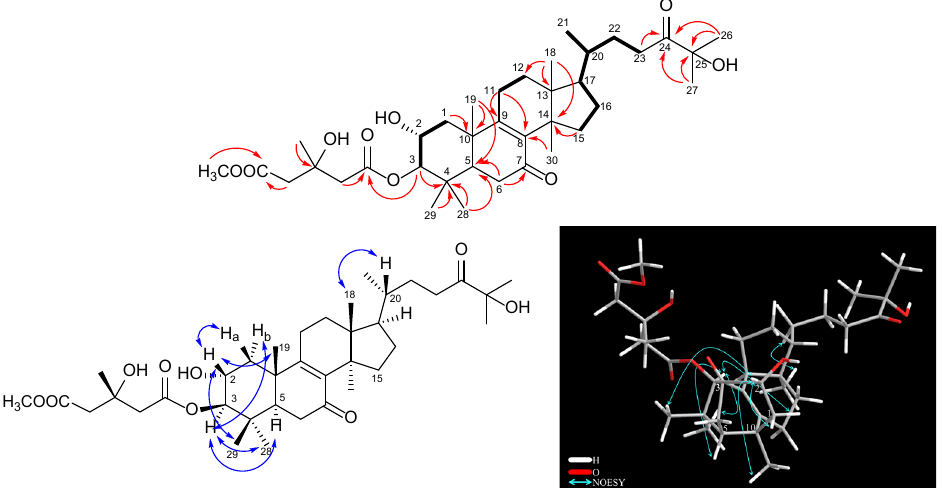
for their β position, similar to the previously isolated pholiol compounds [11,12]. All of the above evidence confirmed the structure of pholiol L ( 1 ), as depicted in Figure 1.